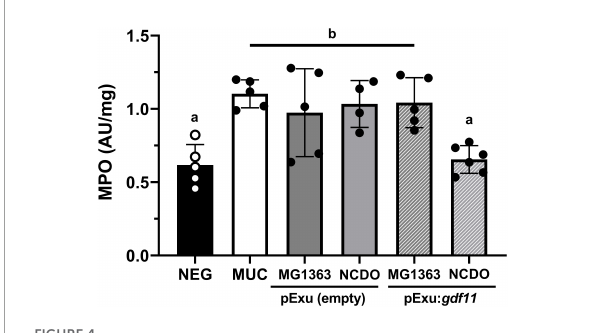
FIGURE4 Effect of recombinant L. lactis (pExu: gdf11 ) on myeloperoxidase activity (MPO) on the ileum of mice ( n = 5). Different letters (a and b) indicate a significant difference ( p < 0.05) among groups by one-way ANOVA and Tukey’s